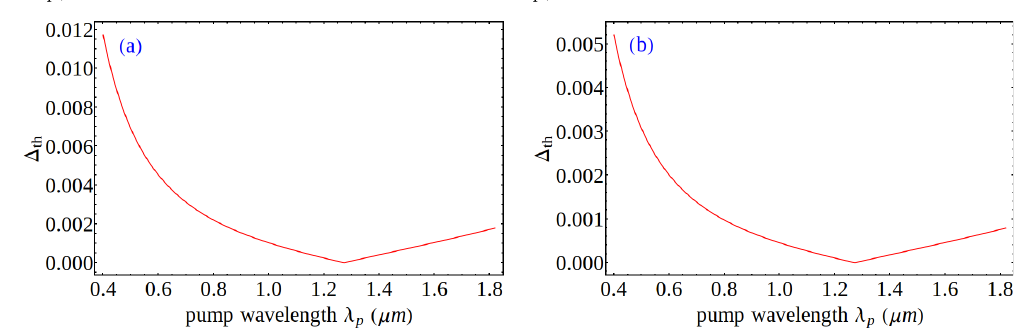
Figure 2. The lower-bound for the relative step index is plotted as a function of the pump wavelength for scenarios depicted in Figure 1 and Equation (2): ( a ) for scenario (a) with Ω = ω / 2 ; and ( b ) for scenario (b) with Ω = ω p